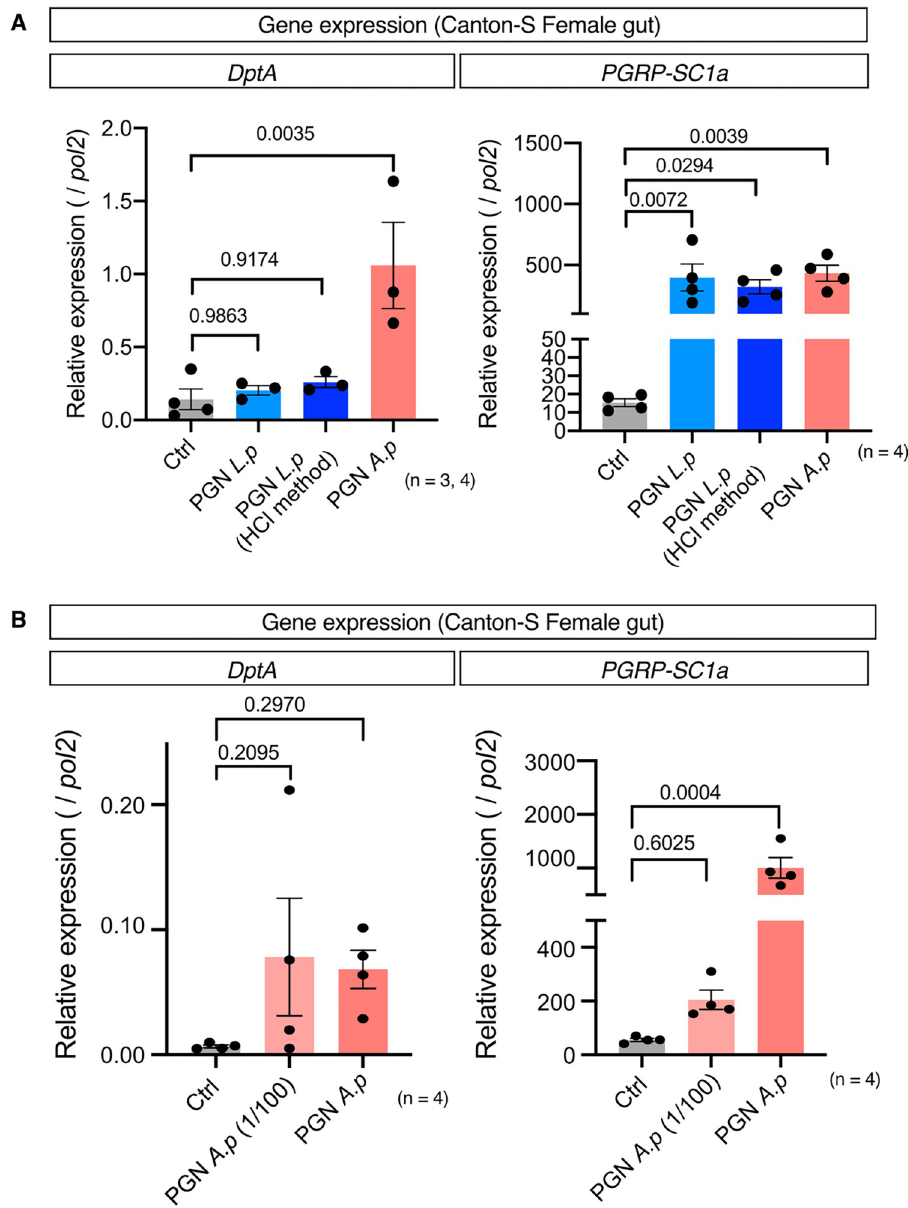
Fig 7. Feeding L . plantarum Lsi and A . persici Ai purified peptidoglycans. (A) Quantitative RT–PCR of the genes DptA and PGRP-SC1a in female fly Canton-S guts after 24 hours of purified peptidoglycan diet with the same concentration (measured and calculated by OD 254 ). For the statistics, ANOVA with Holm-Sˇı´da´k’s multiple comparison was used. (B) Quantitative RT–PCR of the genes DptA and PGRP-SC1a in female fly Canton-S guts after 24 hours of A . persici Ai purified peptidoglycan (1 or 100 times dilution) diet with (measured and calculated by OD 254 ). For the statistics, ANOVA with Holm-Sˇı´da´k’s multiple comparison was used. The control diet is the antibiotics- contained diet. Sample sizes (n) and P values are in each figure.